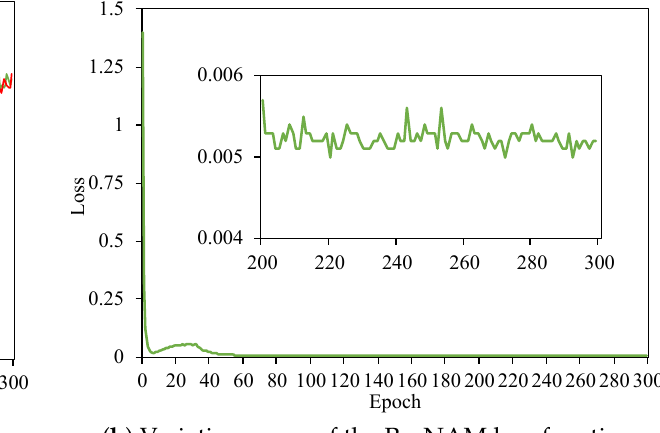
( a ) Change curve of the ResNAM model’s accuracy ( b ) Variation curve of the ResNAM loss function Figure 6. The change curve of each parameter during the training